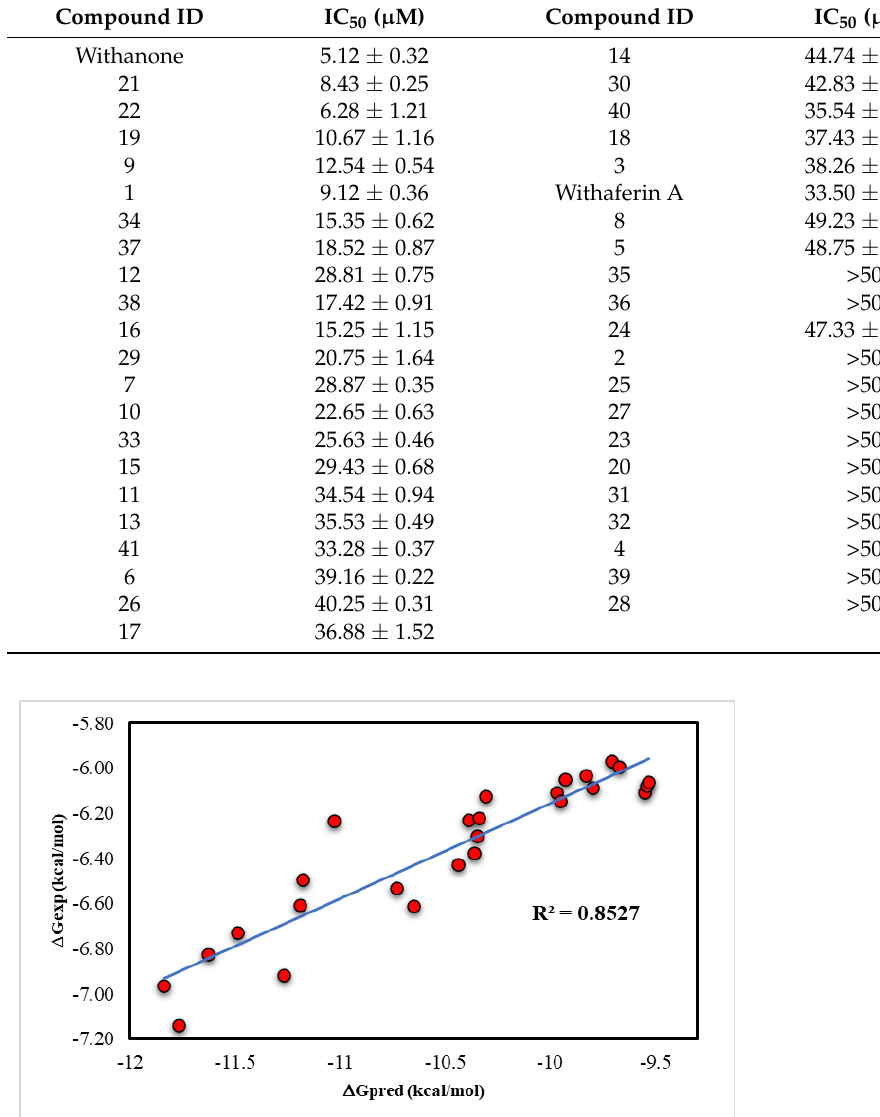
Figure 2. The correlation between experimental and computational binding free energies. Applying Lipinski’s Rule of Five and pharmacokinetic parameters in combination with obtained dock score, nine compounds were considered as promising for further drug development including compounds 14 , 16 , 17 , 18 , 19 , 21 , 22 , 34 and 38 . The stereoview of the binding mode of nine potential inhibitors of protein Mortalin is depicted in Figure S2. It was shown that the occurrence of Mortalin-p53 binding abrogation on Mortalin model 3N8E requires interaction on key amino acid residues, such as Leu450, Ser473, Gln479 and Arg513 at the active site of protein [19,20]. Arg 513, due to its position of the “latch” between the “lid and cleft regions” of mortalin, has been highlighted as the key residue determining the chaperone function of the protein [34]. As indicated from Table S2, all nine compounds exhibited hydrogen bond interactions, with essential residues in the p53- binding site of Mortalin. Compound 21 displayed the best pharmacophore fit scores com- pared to the others, which formed four H-bonds with Leu450; Glu483; Arg513; Asn583 (Figures 3 and S2). Compound 22 formed 3 hydrogen bonds with key residues: Glu448, Glu483 and Arg513, whereas compound 19 formed two H-bonds with Ser473—both Arg513. The obtained results suggest that interaction with these residues contribute to disrupting interaction between Mortalin and p53, thus, reactivate the function of p53. Re- garding toxicity prediction (Table S1), it should be noted that, amongst 9 “hits”, com- pounds 16 , 17 , 19 and 21 being ranked as non-toxic for human (rank 6), therefore, they could be assumed as the most suitable for further drug development. Compounds 14 , 22 and 38 also fell within the safe zone, with their rank being in the range between 4 and 5. Compounds 18 and 34 are classified as possibly toxic at high doses, thus suggesting that they are inappropriate for future drug development.